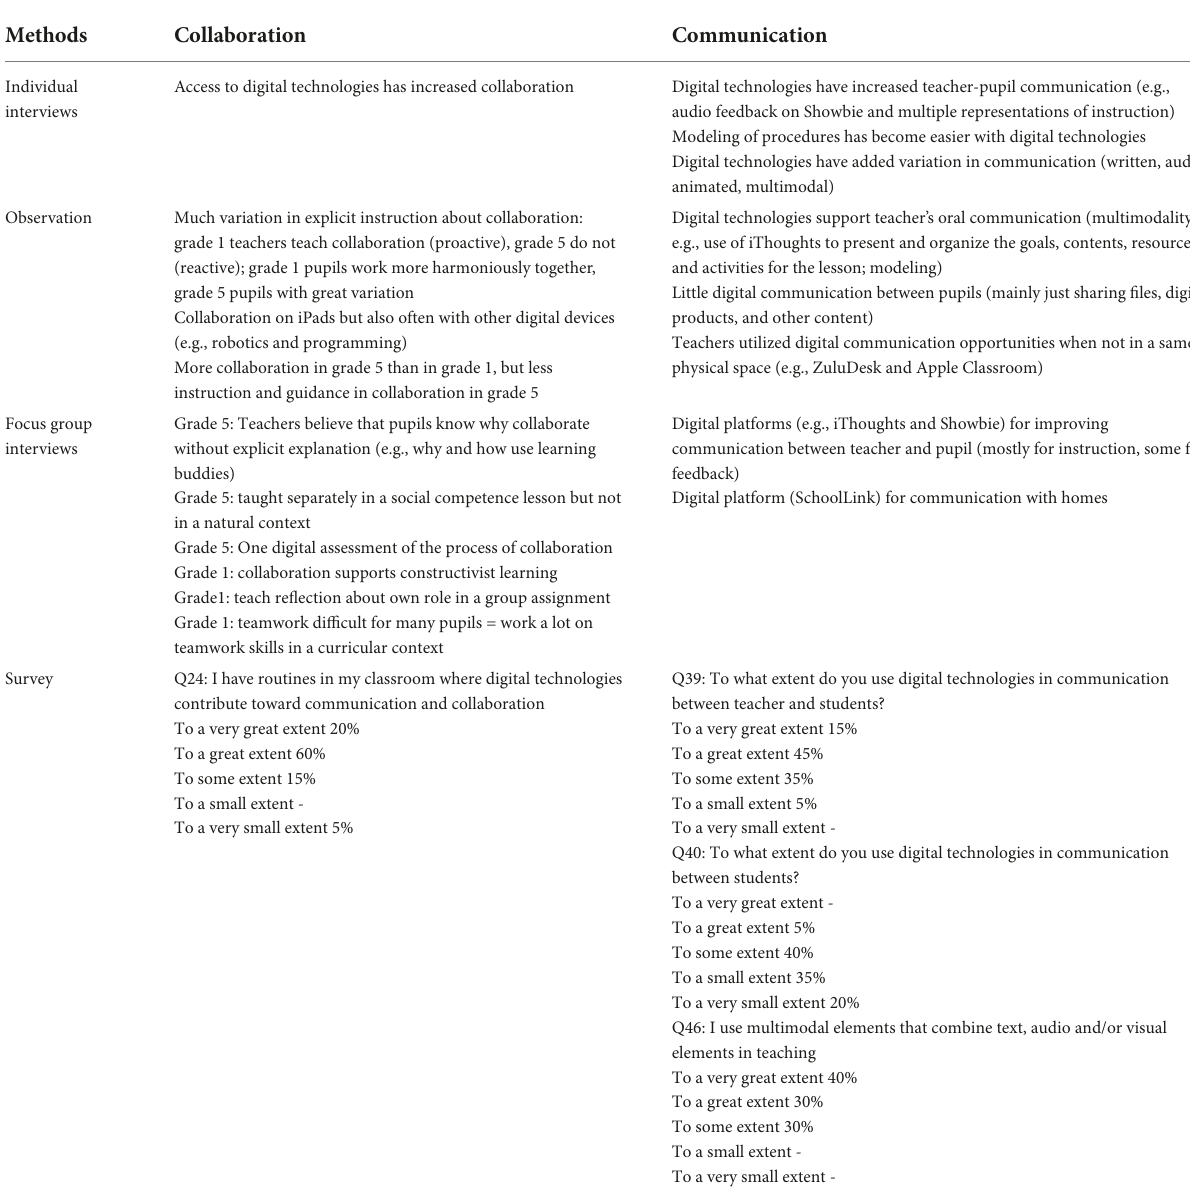
TABLE 2 Overview of findings in all